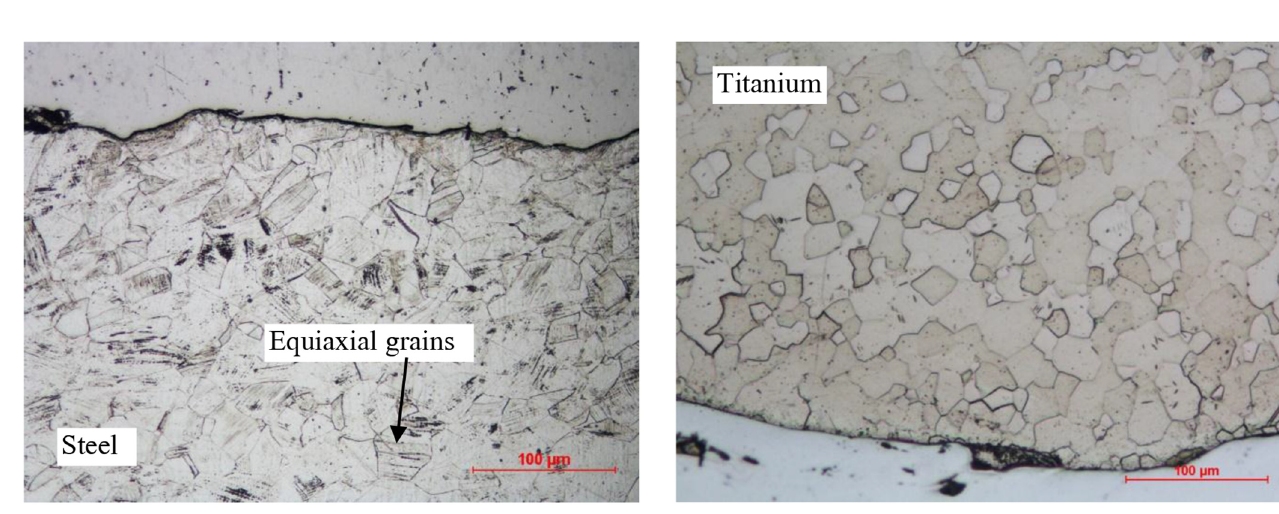
Fig. 6. Microstructure of titanium near the bond in specimen after the heat treatment.